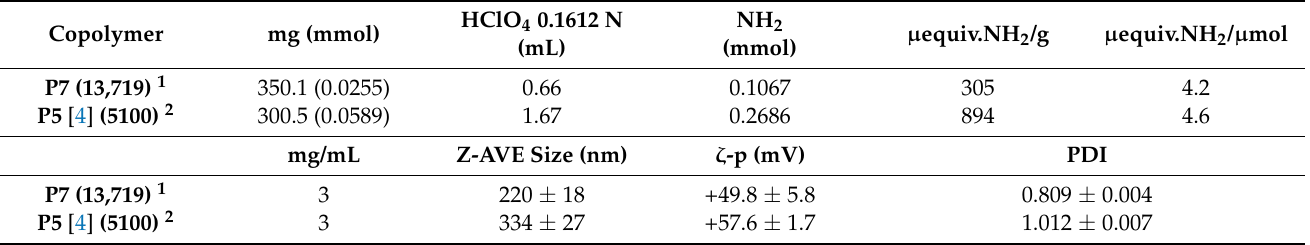
Table 3. Results of volumetric titration of an exactly weighted amount of P7 and P5 [4]. Hydrodynamic size (nm), ζ -p, and PDI at 37 ◦ C of P7 and P5 [4] by DLS analysis (degree of freedom n =